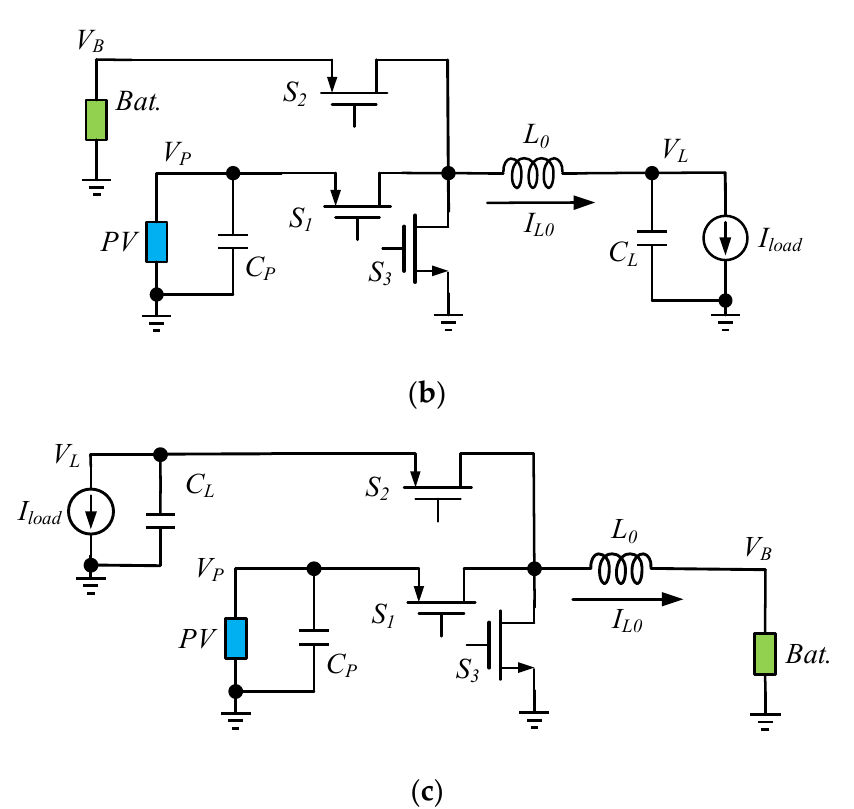
Figure 1. ( a ) 2P6S converter, ( b ) 2P3S converter, ( c ) 1P3S converter.